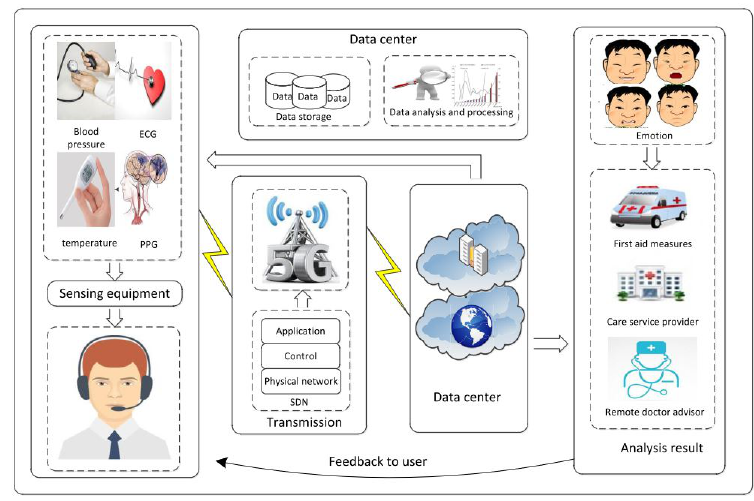
Figure 6. Presented emotion-aware healthcare in [29].